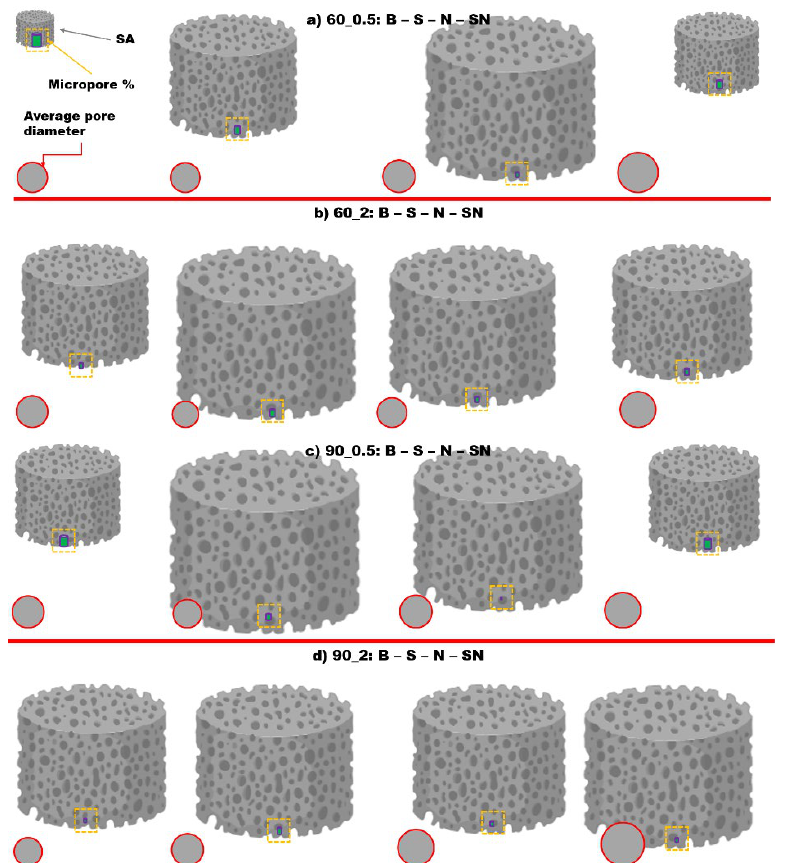
Figure 7. Illustration of the monoliths (B: blank, S: TMOS, N: TMON, and SN: TMOSN) in respect of the SA (grey 3D cylinder), the micropores percentage (orange square), and average pore diameter (red circle) for systems: ( a ) 60_0.5; ( b ) 60_2; ( c ) 90_0.5; ( d ) 90_2.